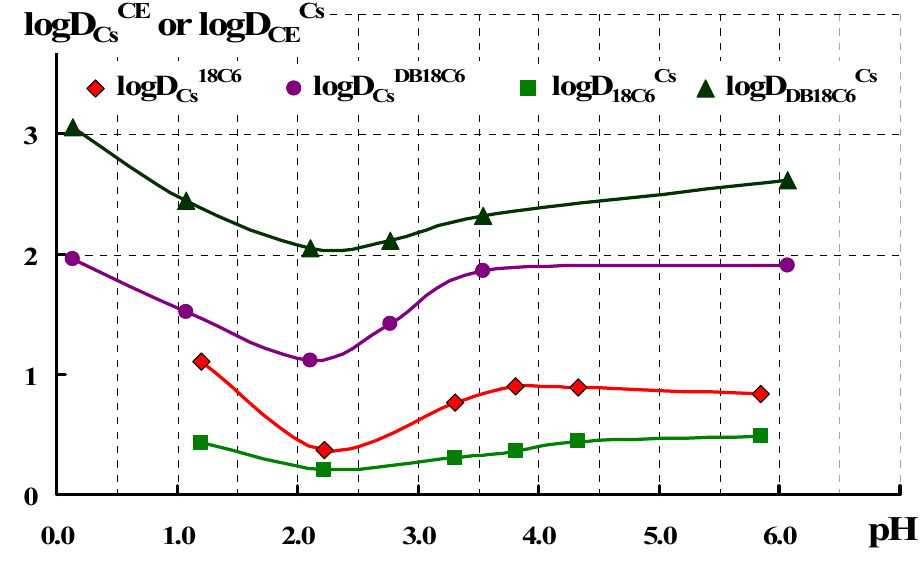
Figure 1. Distribution of cesium, 18C6, and DB18C6 vs. pH in [TOMA][Sal] based